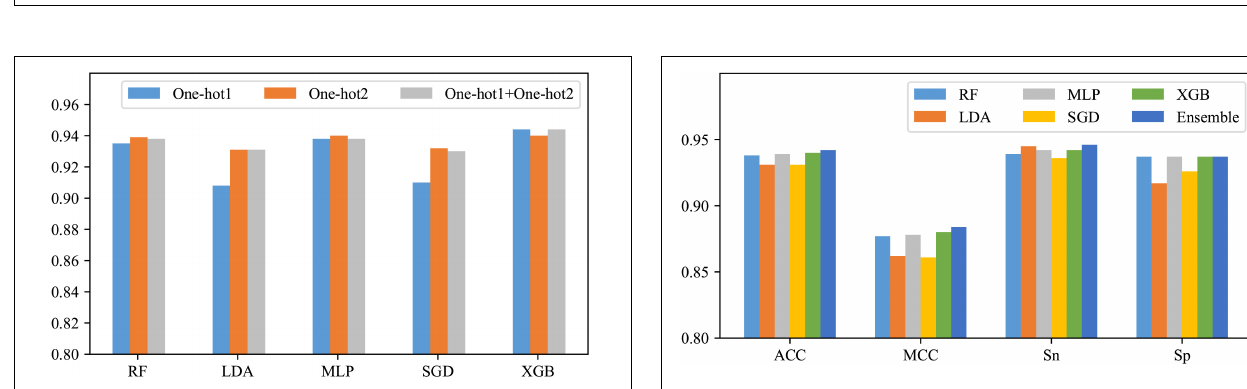
FIGURE 4 | Comparison before and after feature fusion.